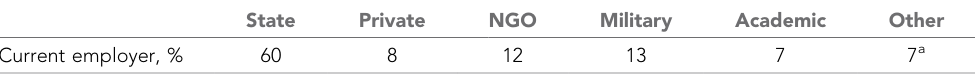
Table 4. Distribution of clinical associates by current employment